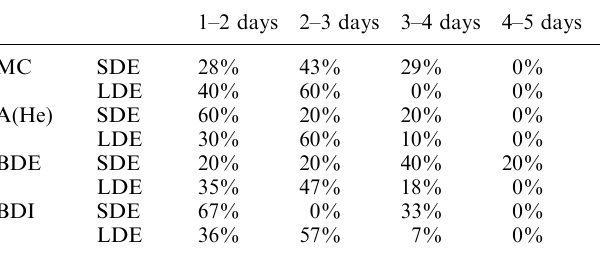
Table 7. Time-delays for X-ray